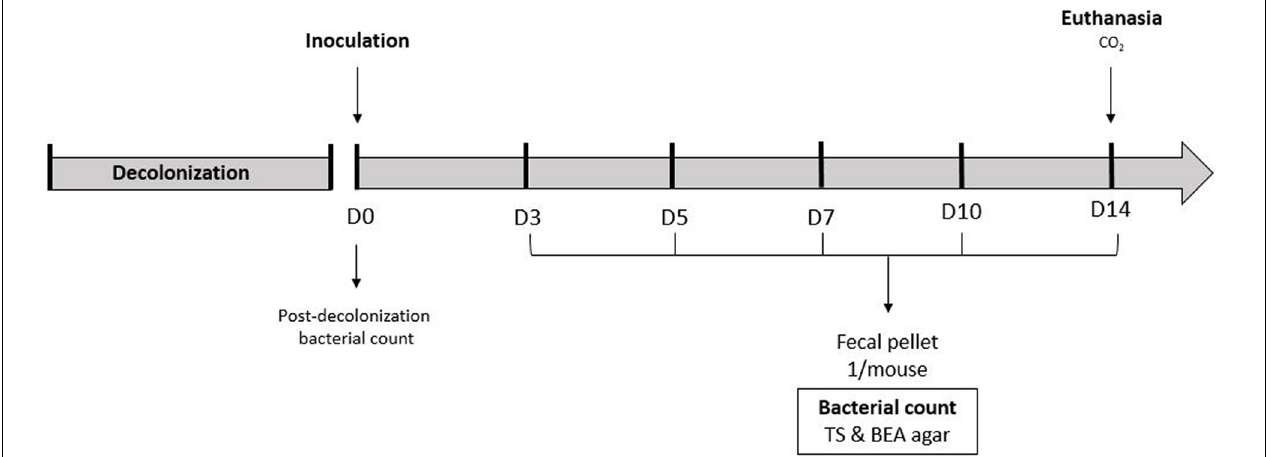
FIGURE 1 | GIT colonization model used to compare antibiotic